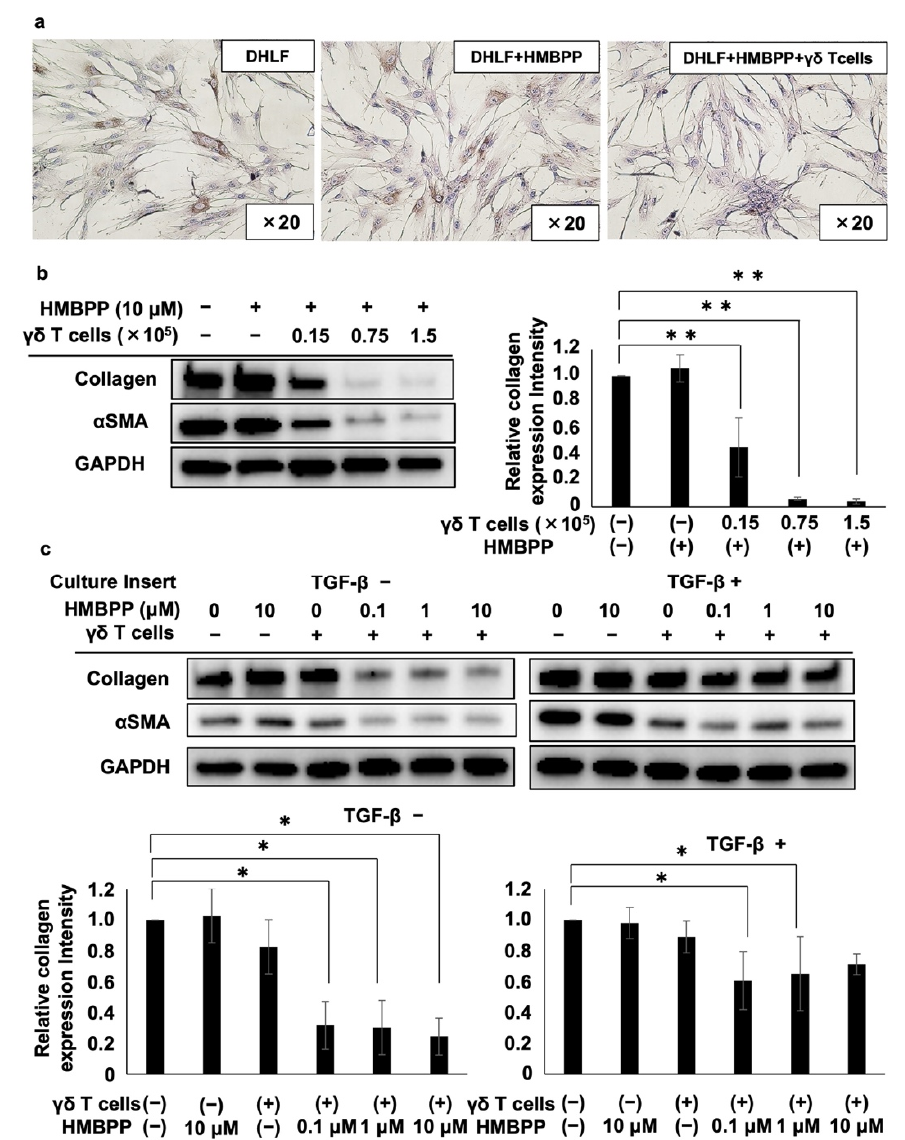
Figure 3. Effect of HMBPP on γδ T cell-mediated suppression of collagen in lung fibroblasts. ( a ) Immunocytochemical analysis of collagen type I in lung fibroblasts challenged with HMBPP-activated γδ T cells. DHLF cells (2.5 × 10 4 ) were incubated overnight in a Lab-Tek chamber slide. γδ T cells (5.0 × 10 3 ) or RPMI 1640 medium in the presence or absence of 10 μ M HMBPP were then added. The slide was incubated for 2 days, and collagen type I levels in DHLF cells were then measured. ( b ) Western blot analysis of collagen type I and α SMA in lung fibroblasts challenged with HMBPP-activated γδ T cells. DHLF cells (1.5 × 10 5 ) were cultured overnight in a 6-well plate. γδ T cells (0, 0.15 × 10 5 , 0.75 × 10 5 , or 1.5 × 10 5 ) in the presence or absence of HMBPP (10 μ M) were then added. After co-culturing for 2 days, collagen type I and α SMA protein levels in DHLF cells were deter- mined via Western blot analysis. ( c ) Western blot analysis of collagen type I and α SMA in TGF- β - pretreated lung fibroblasts challenged with HMBPP-activated γδ T cells through culture membrane inserts. DHLF cells (1.5 × 10 5 ) were incubated overnight in the presence (right panel) or absence (left panel) of TGF- β (5 ng/mL). The cells were washed with PBS (-), and γδ T cells (5 × 10 6 ) diluted serially with HMBPP (0, 0.1, 1, or 10 μ M) were added through the culture membrane inserts. After incubation for 2 days, collagen type I and α SMA levels in DHLF cells were analyzed via Western blot analysis. Relative collagen expression was calculated by normalization to GAPDH. Data are presented as mean ± standard deviation and are representatives of three independent experiments. Statistical significance was determined using Dunnett’s test (* p < 0.05, ** p < 0.01).